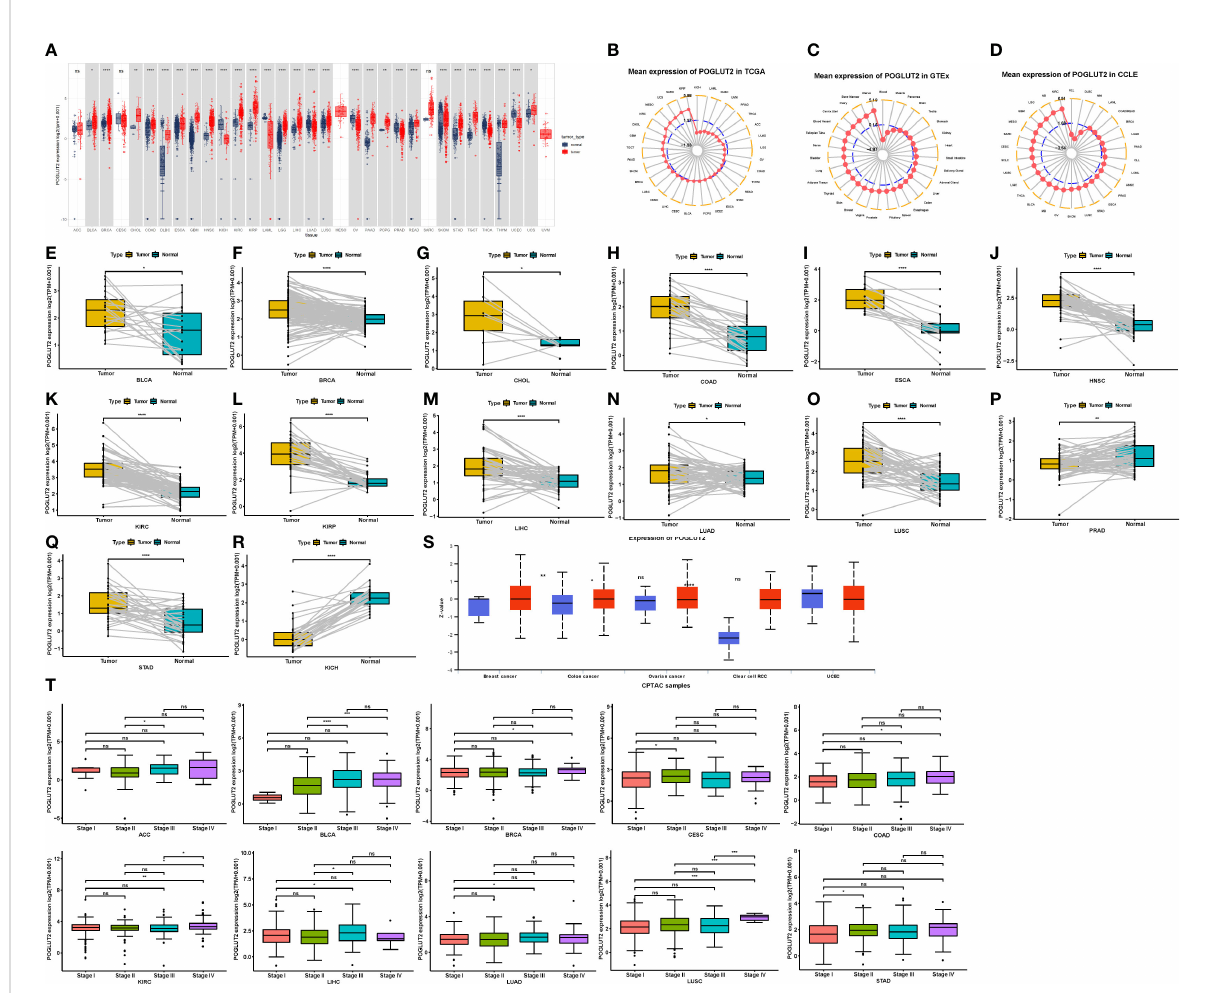
FIGURE 1 Expression pattern of POGLUT2 mRNA in different types of tumors and paired tumor and para-tumor normal tissues. (A) Compared to normal tissue, elevated and decreased levels of POGLUT2 mRNA were respectively found in BLCA, BRCA, CHOL, COAD, DLBC, ESCA, GBM, HNS, KIRC, KIRP, LAML, LGG, LIHC, LUAD, LUSC, OV, PAAD, PCPG, PRAD, READ, STAD, TGCT, THCA, THYM, UCS, UVM, and KICH, OV, THCA, and UCEC, whereas no difference was found in ACC, CESC, MESO, and SARC. (B) Mean expression of POGLUT2 mRNA in different types of tumors from TCGA. (C) Mean expression of POGLUT2 mRNA in different types of tumors from GTEx. (D) Mean expression of POGLUT2 mRNA in different types of tumors from CCLE. Elevated (E – O) and decreased (P – R) levels of POGLUT2 mRNA in paired tumor and para-tumor normal tissues. (S) Expression of POGLUT2 protein in different types of tumors. Elevated POGLUT2 in tumor tissue compared to normal tissue was found in breast cancer, colon cancer, and renal clear cell carcinoma, whereas no difference was found in ovarian cancer and UCEC (data are from UALCAN database). (T) The relationship between POGLUT2 mRNA level and pathology stages in different types of tumors. Elevated POGLUT2 mRNA level was found in tumors derived from high stages compared to lower stages. TCGA, The Cancer Genome Atlas; GTEx, Genotype-Tissue Expression; CCLE, Cancer Cell Line Encyclopedia. ns, no signi fi cant. *P < 0.05, **P < 0.01, ***P <